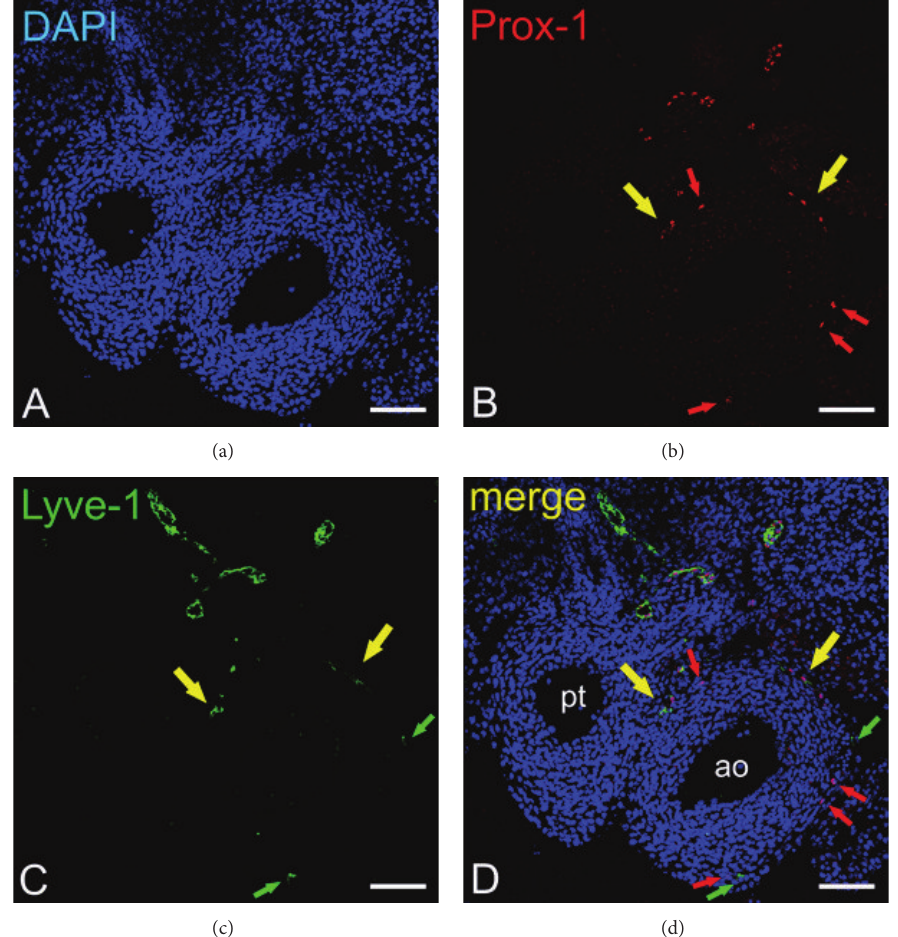
Figure 3: Confocal microscopy images of a 14-dpc mouse heart stained with DAPI (blue), anti-Prox-1 (red), and anti-Lyve-1 (green). Lyve- 1-positive cells (green arrows), Prox-1-positive cells (red arrows), and Lyve-1/Prox-1-double positive vessels (yellow arrows) are visible along the great arteries; ao—aorta; pt—pulmonary trunk; scale bars = 100 𝜇 m.